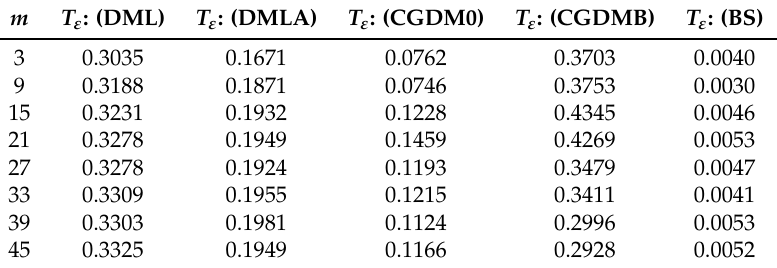
Table 12. Results for Case EQ with J = 510, ε = 10 − 2 .